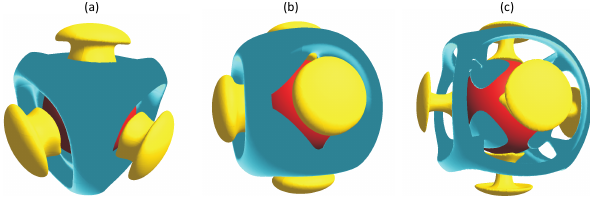
Fig. 5. Representative temperature anomalies from thermal ampli- tude convection tests for: (a) tetrahedral symmetry at Ra = 7 × 10 3 ; (b) cubic symmetry at Ra = 3 . 5 × 10 3 ; and (c) cubic symmetry at Ra = 1 × 10 5 respectively. Yellow and blue isosurfaces represent ra- dial temperature anomalies of 250 and –250K respectively. These results are from the highest resolution non-uniform cases of Table